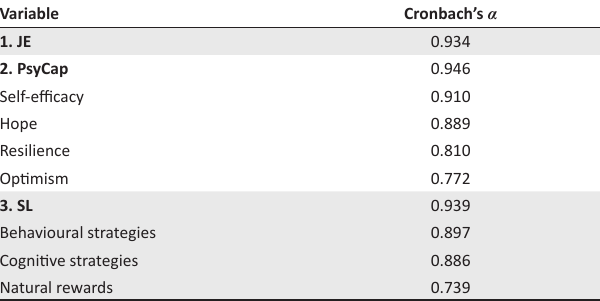
TABLE 1: Reliability estimates for the psychological capital, self-leadership and job embeddedness scale ( N = 303).